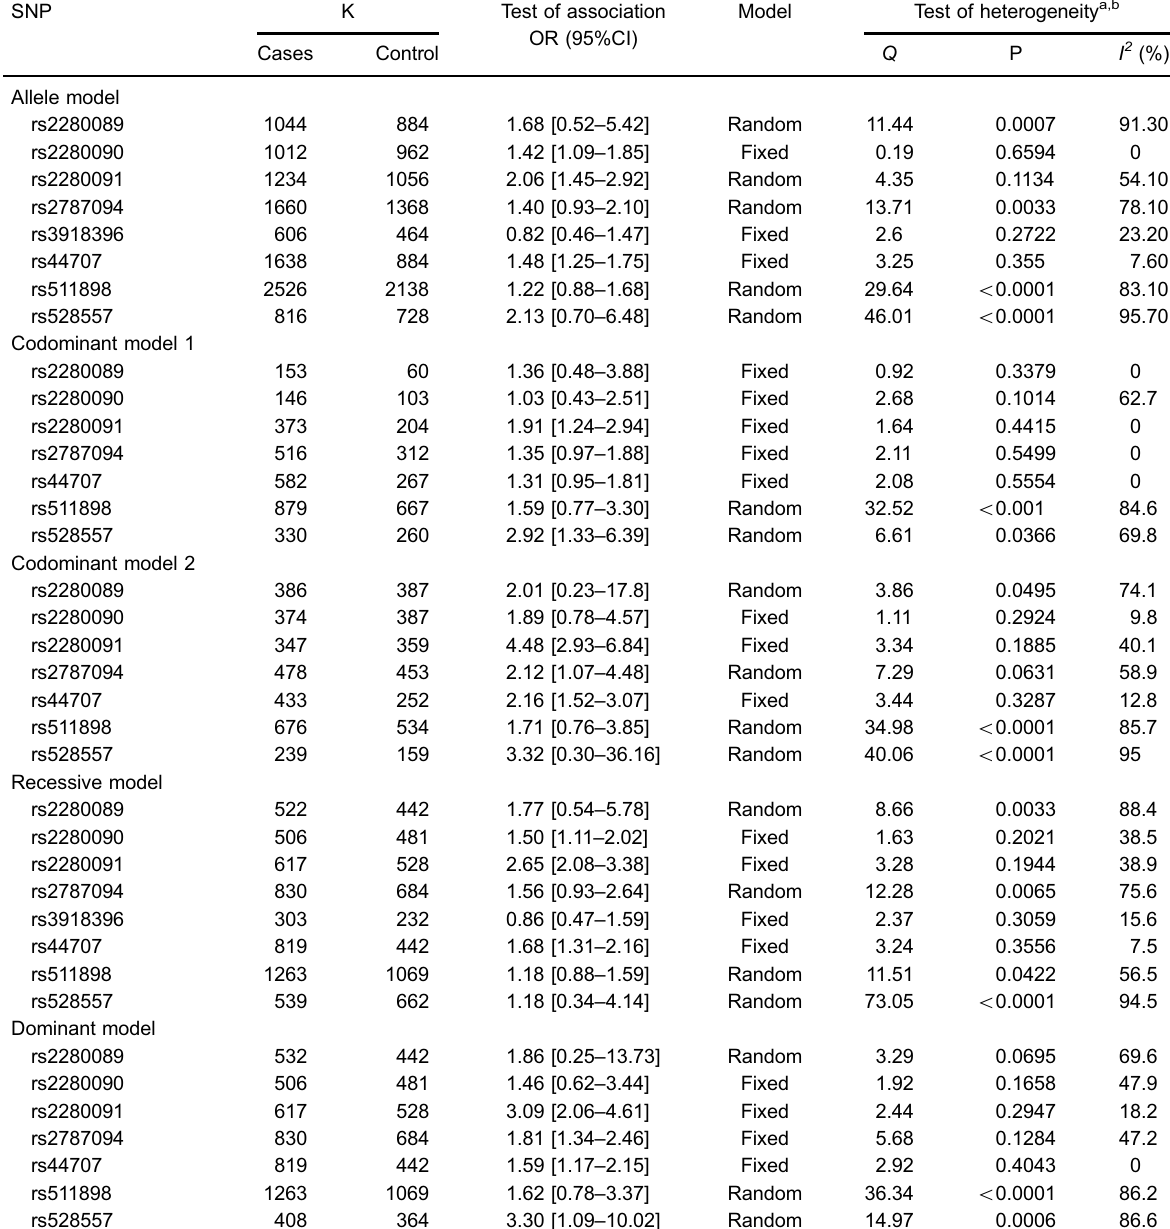
Table 3. Meta-analysis results of association between ADAM33 and childhood